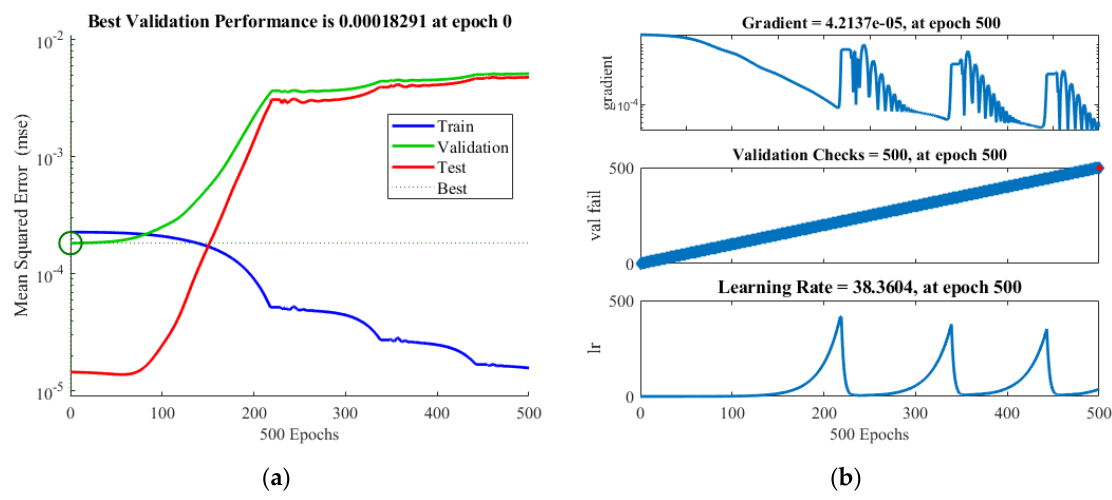
Figure 7. Relationship between simulation values and ANN model values for displacement. ( a ) the best validation performance at epoch 0; ( b ) Gradient at epoch 500.